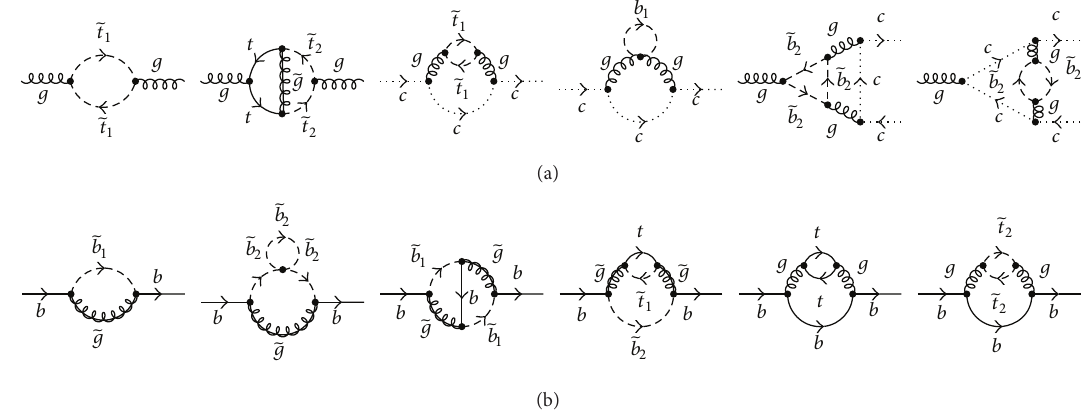
̃𝜁 ̃𝜁 𝜁 𝑔 ), ghosts ( 𝑐 ), bottom/top quarks ( 𝑏/𝑡 ), bottom/top squarks ( ̃𝑏/̃𝑡 ), 3 , 1 , and 𝑚 with gluons (